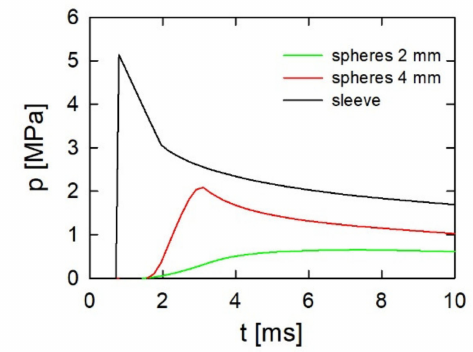
Figure 10. Averaged pressure courses for various fillings of the chamber.